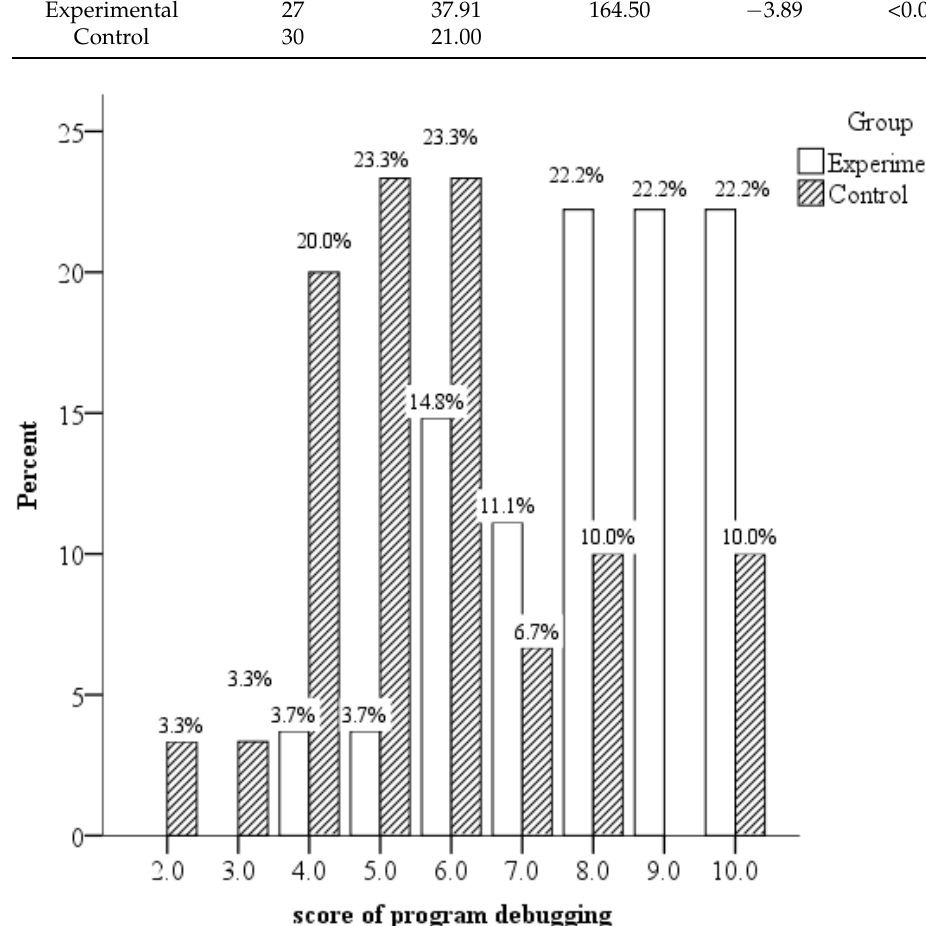
Figure 4. Distribution of program debugging scores.